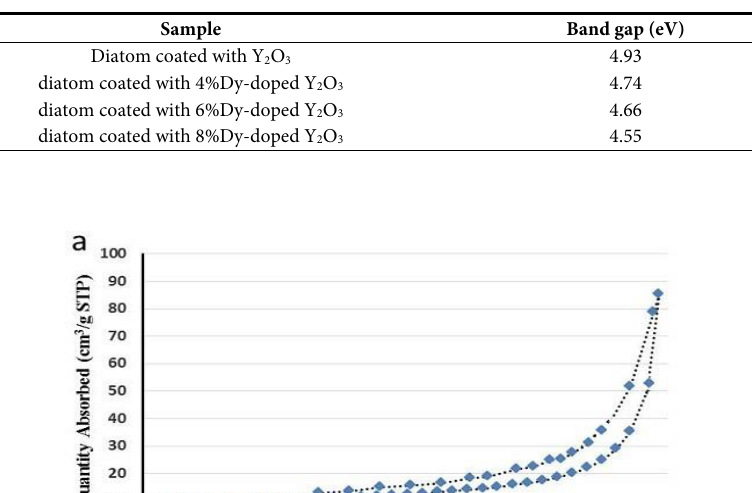
Table 3. Band gap energy of diatom coated with Eu-doped Y 2 O 3 nanostructures.